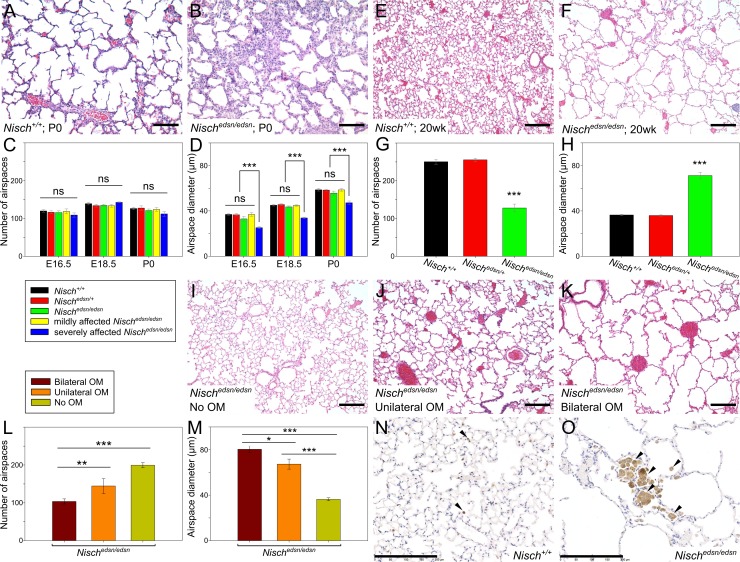
Nischedsn/edsn mice display embryonic and adult lung abnormalities.(A-D) At E16.5, E18.5 and P0, some Nischedsn/edsn embryos display lung abnormalities. H&E stained lung sections from (A) Nisch+/+ and (B) severely affected Nischedsn/edsn mice at P0, show thickened interstitial mesenchyme and smaller airspaces in Nischedsn/edsn lungs. (C) Number of airspaces was counted in three different 6.5 x 105 μm2 regions for all embryos and new born mice, with no significant difference between genotypes. (D) Airspace diameters were measured for 30 airspaces in three different regions for all embryos and new born mice. The mean airspace width in severely affected Nischedsn/edsn animals was significantly smaller. Nisch+/+ n = 6–9; Nischedsn/+ n = 11–15; Nischedsn/edsn n = 6–10; mildly affected Nischedsn/edsn n = 4–7; severely affected Nischedsn/edsn n = 2–3. (E-H) Adult Nischedsn/edsn mice exhibit an emphysema-like phenotype. H&E stained lung sections from (E) Nisch+/+ and (F) Nischedsn/edsn animals at 20 wk, show enlargement of air spaces in Nischedsn/edsn lungs accompanied by disruption of normal alveolar architecture. (G) In Nischedsn/edsn lungs quantification of the number of airspaces indicated a significant decrease compared to wild-type and (H) the mean airspace width in Nischedsn/edsn lungs was significantly larger than in wild-type tissue. Nisch+/+ n = 10; Nischedsn/+ n = 10; Nischedsn/edsn n = 18. (I-M) The severity of the emphysema-like lung phenotype observed in Nischedsn/edsn replicates the severity of the OM phenotype in the middle ear. H&E stained lung sections from Nischedsn/edsn animals at 20 wk show the increasing severity of the emphysema-like phenotype from mice with (I) no OM phenotype, to (J) unilateral OM and to (K) bilateral OM. (L) The mean number of airspaces in Nischedsn/edsn animals with no OM phenotype was significantly increased compared to Nischedsn/edsn animals with bilateral OM. (M) The mean airspace width in Nischedsn/edsn mice with no OM phenotype was significantly smaller than Nischedsn/edsn animals with bilateral OM. Bilateral OM n = 10; Unilateral OM n = 6; Clear n = 2. (N, O) Immunohistochemical staining of lung sections using an F4/80 antibody. Lung sections from (N) Nisch+/+ and (O) Nischedsn/edsn animals at 20 wk stained with F4/80 show collections of enlarged alveolar macrophages (brown) in Nischedsn/edsn lungs compared to wild-type littermates. Representative images from four mice per genotype. N, O scale bar = 200 μm; A, B, E, F, I, J, K scale bar = 100 μm. ns P > 0.05; * P < 0.05; ** P < 0.01; *** P < 0.001. Error bars indicate standard error of mean. Embryonic lung data in panels C and D were analysed by one-way ANOVAs and Holm-Sidak’s multiple comparison procedures for post-hoc testing. Adult lung data (G, H, L, M) was not normally distributed and a Kruskall-Wallis test was performed followed by Dunn’s multiple comparison tests for post-hoc analysis.